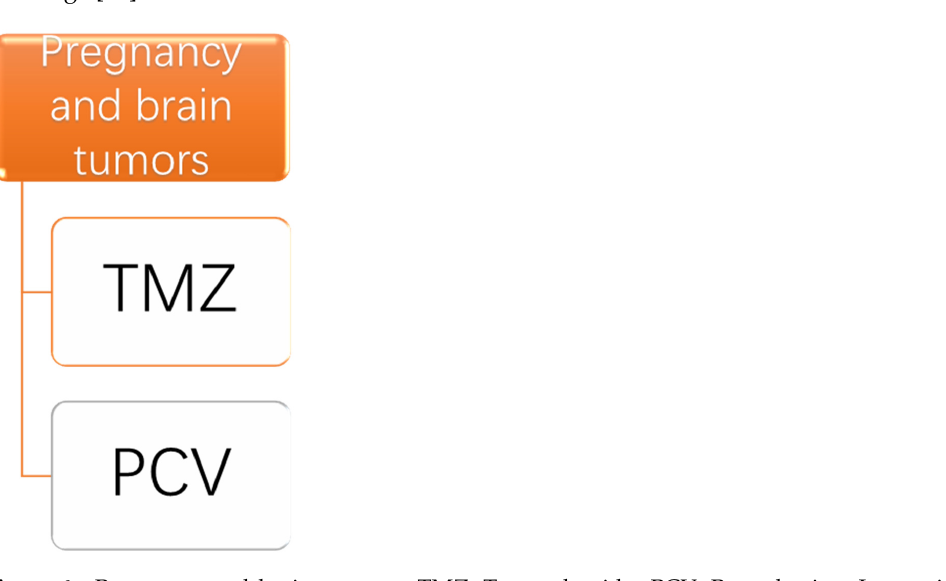
Figure 6. Pregnancy and brain tumors. TMZ: Temozolomide; PCV: Procarbazine, Lomustine and Vicristin .